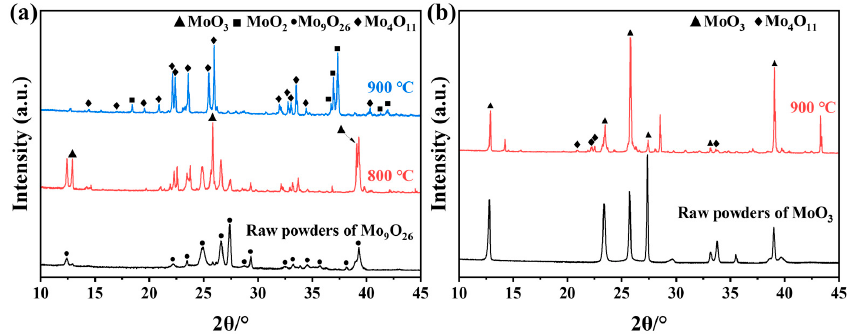
Figure 5. XRD patterns of the Mo 9 O 26 ( a ) and MoO 3 ( b ) powders after heat